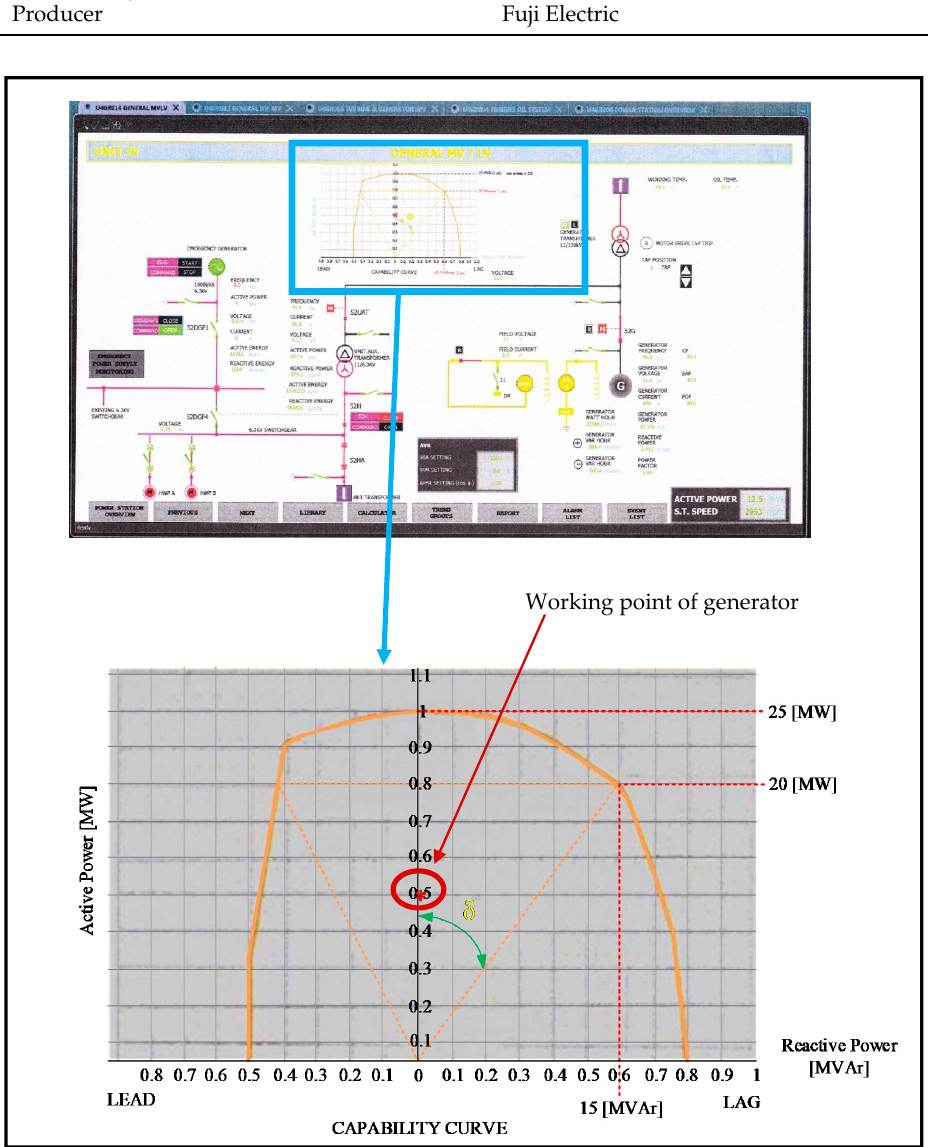
Figure 13. Original capability curve from the generator in Lahendong IV geothermal power plant.